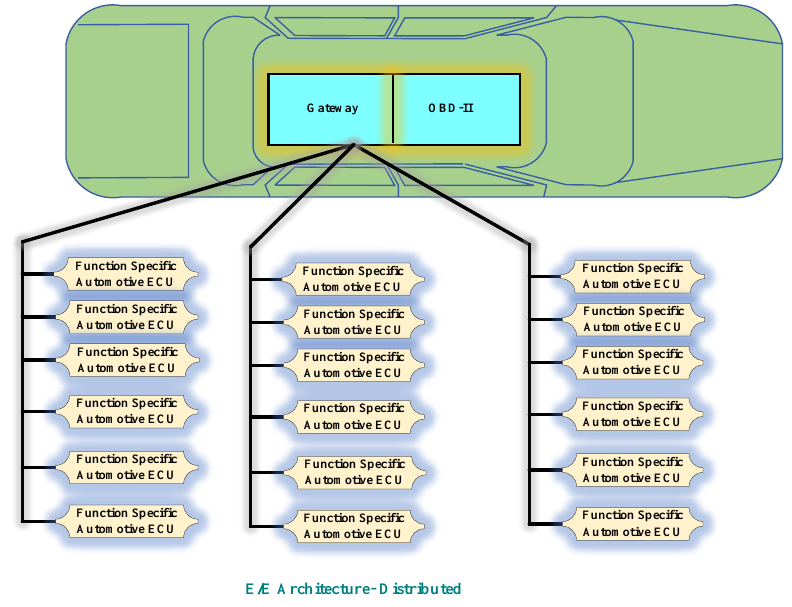
Figure 4. E/E Architecture-Distributed.